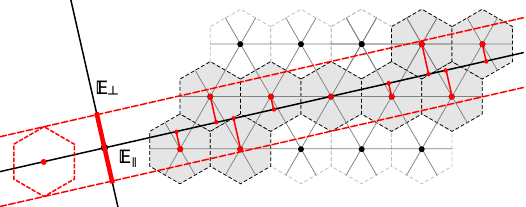
Figure 3. A tiling T ( A 2 ) defined as a projection A 2 → E 1 of the triangular lattice to the line. The cut-window W = V ⊥ is an interval in E ⊥ (thick red line) and dictates which lattice points λ are selected for the tiling T : if a lattice points falls within the cut-window λ ⊥ ∈ W then it is included in the tiling λ ∈ T